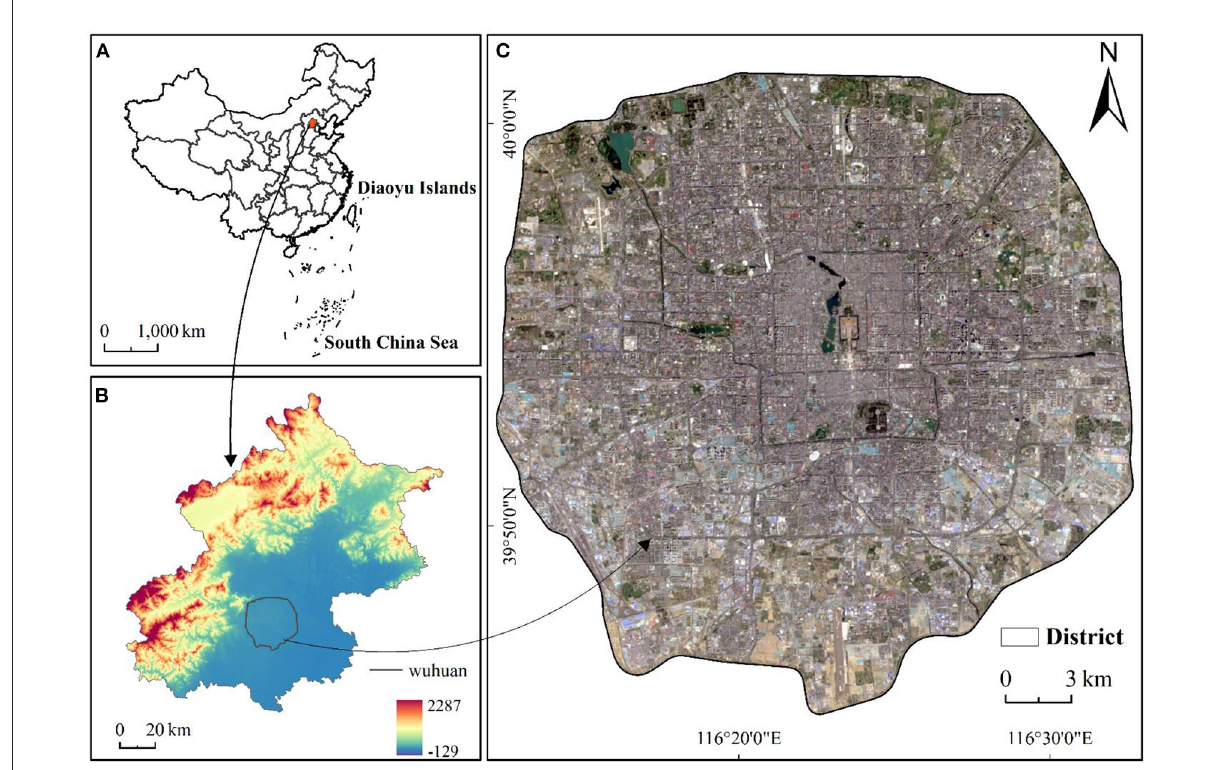
FIGURE1 The location of the study area. (A) The red shaded area represents the location of the study area in China, (B) Beijing decorated with elevation data, and (C) satellite images of the study area.